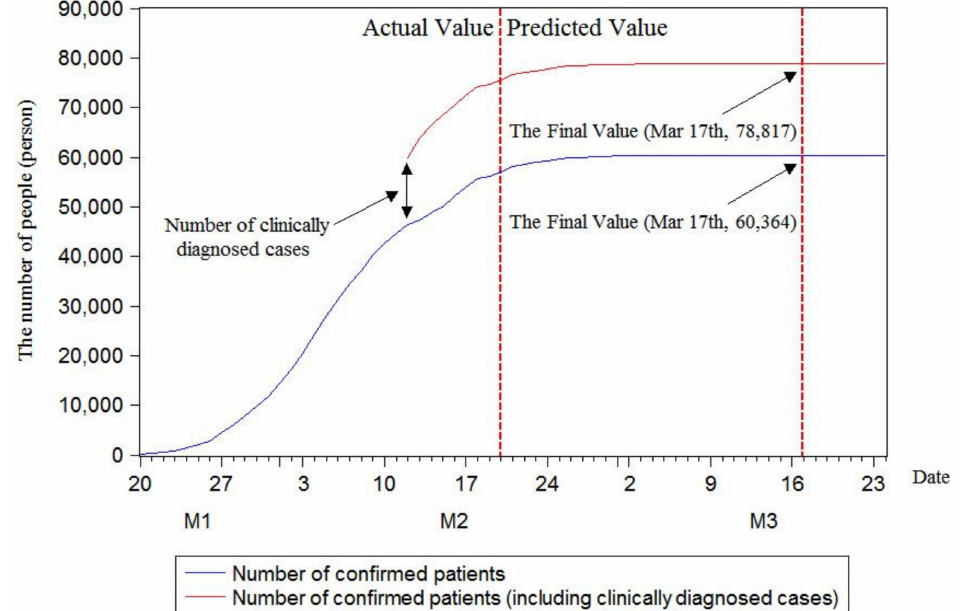
Figure 5. Model prediction with rolling sequence length of